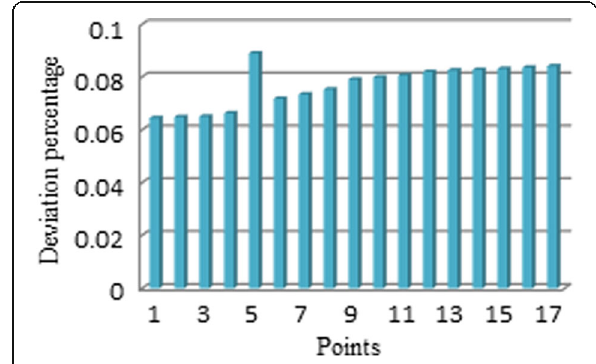
Fig. 14 The deviation percentage of the requirement values in 17 defined points of the pieces